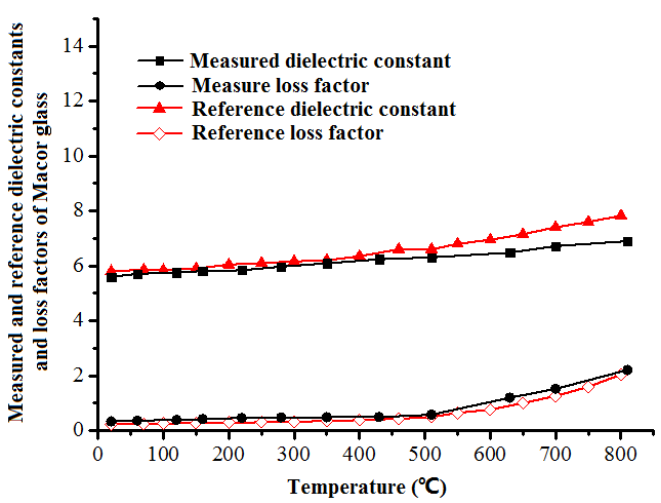
Figure 5. Comparison of measured and reference dielectric properties of Macor glass.